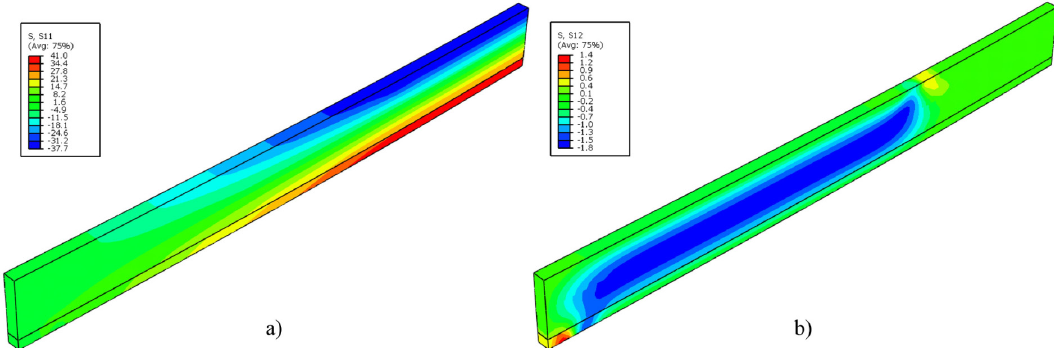
Fig. 9. Stress (MPa) distributions in glulam at ultimate load for Series A beams: a) normal σ 11 stress and b) shear σ 12